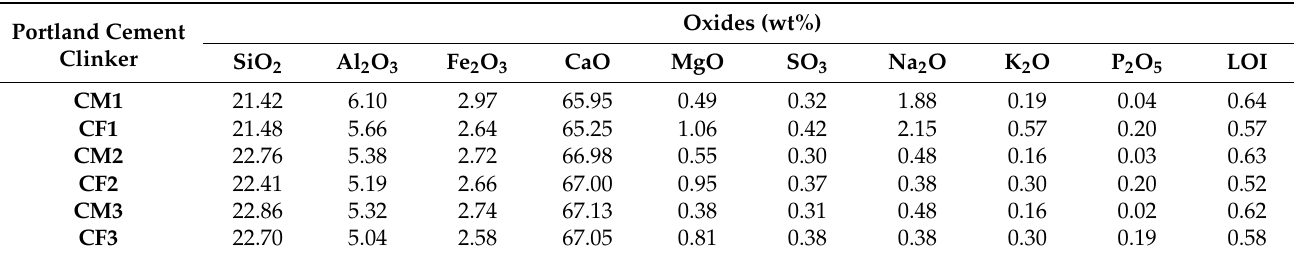
Table 4. Chemical composition of the produced cement